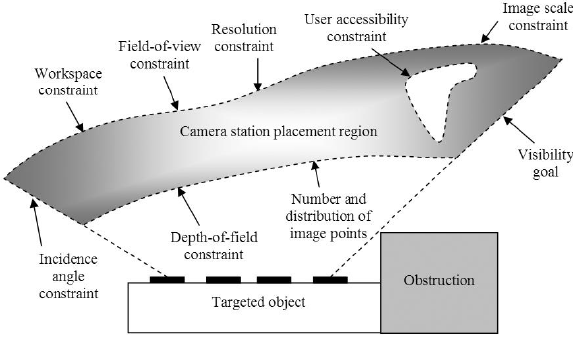
Figure 1. Constraints in photogrammetric network design